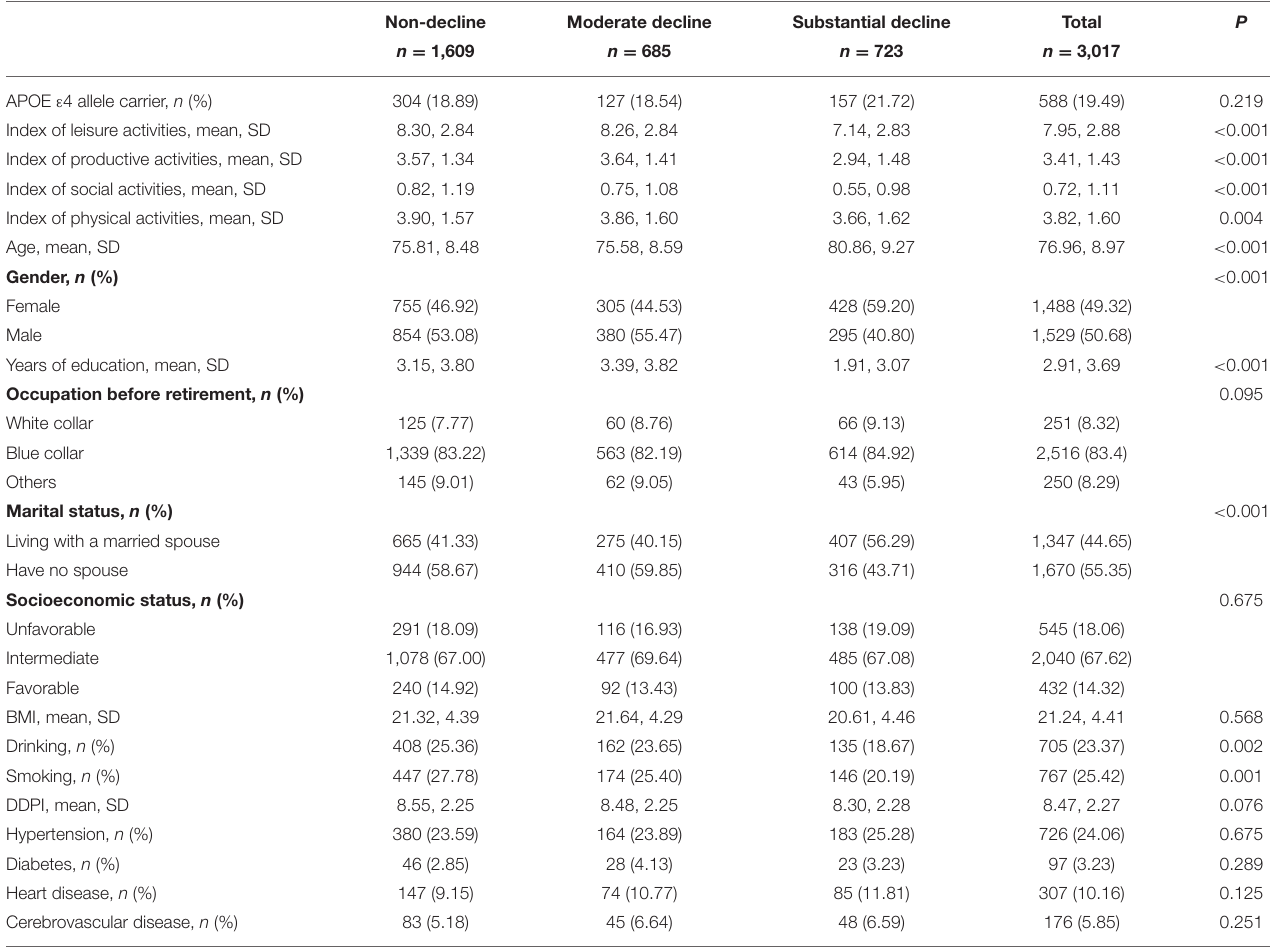
TABLE 1 | Characteristics of participants by levels of cognitive decline between 2008 and